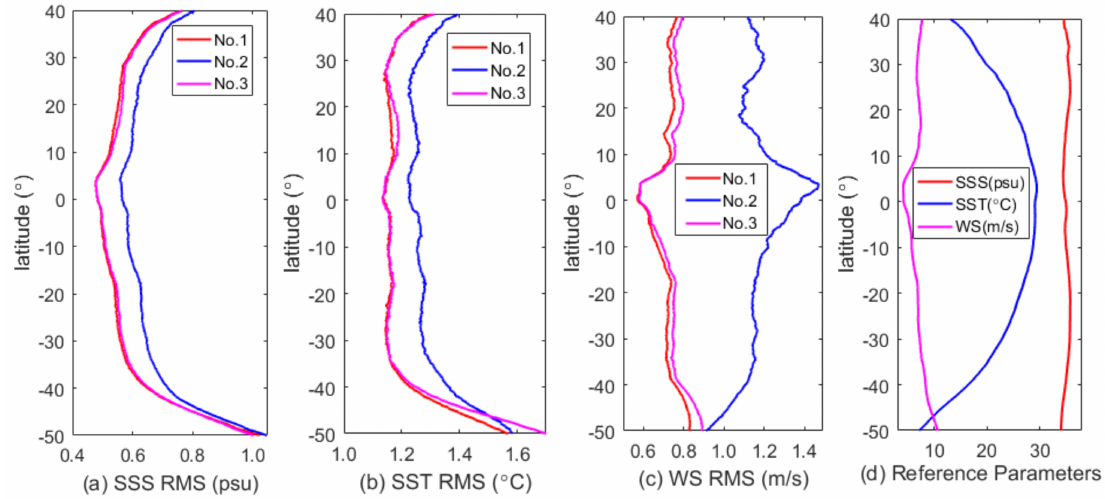
Figure 6. The latitudinal profiles of the errors on the retrieved: SSS ( a ); SST ( b ); and WS ( c ) of MICAP; and the initialized oceanic inputs ( d ). The SSS, SST, and WS errors are denoted by the red, magenta and blue solid line, respectively. The horizontal coordinate of ( d ) represents the range of SSS (red), SST (magenta), and WS